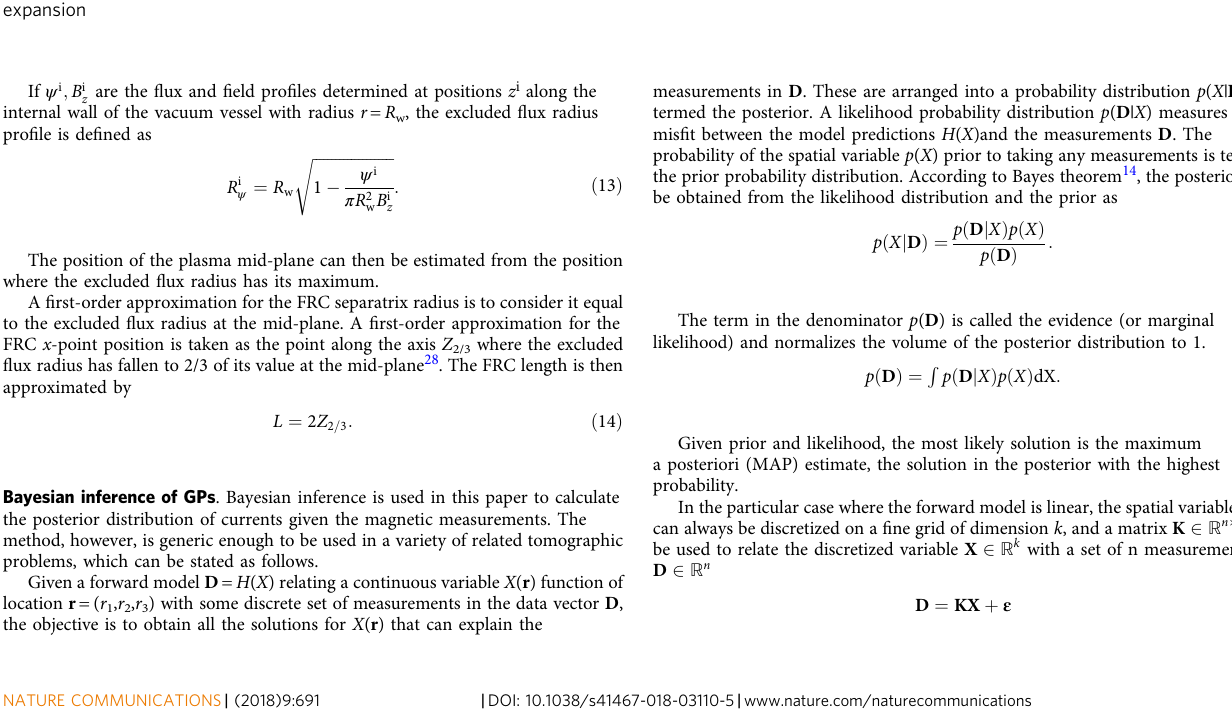
Fig. 6 FRC poloidal fl ux contours. Flux contours (cyan) superimposed with surfaces of equal emissivity from the 3d → 3p oxygen 4+ transition (grey scale). Maximum emissivity is shown in white, while no emissivity is represented by black. The fl ux contour levels corresponding with 0 Wb (separatrix) and 0.01 Wb are labelled to show how fl ux expands in the open fi eld region as the discharge evolves. The region of peak emissivity approximately tracks the fl